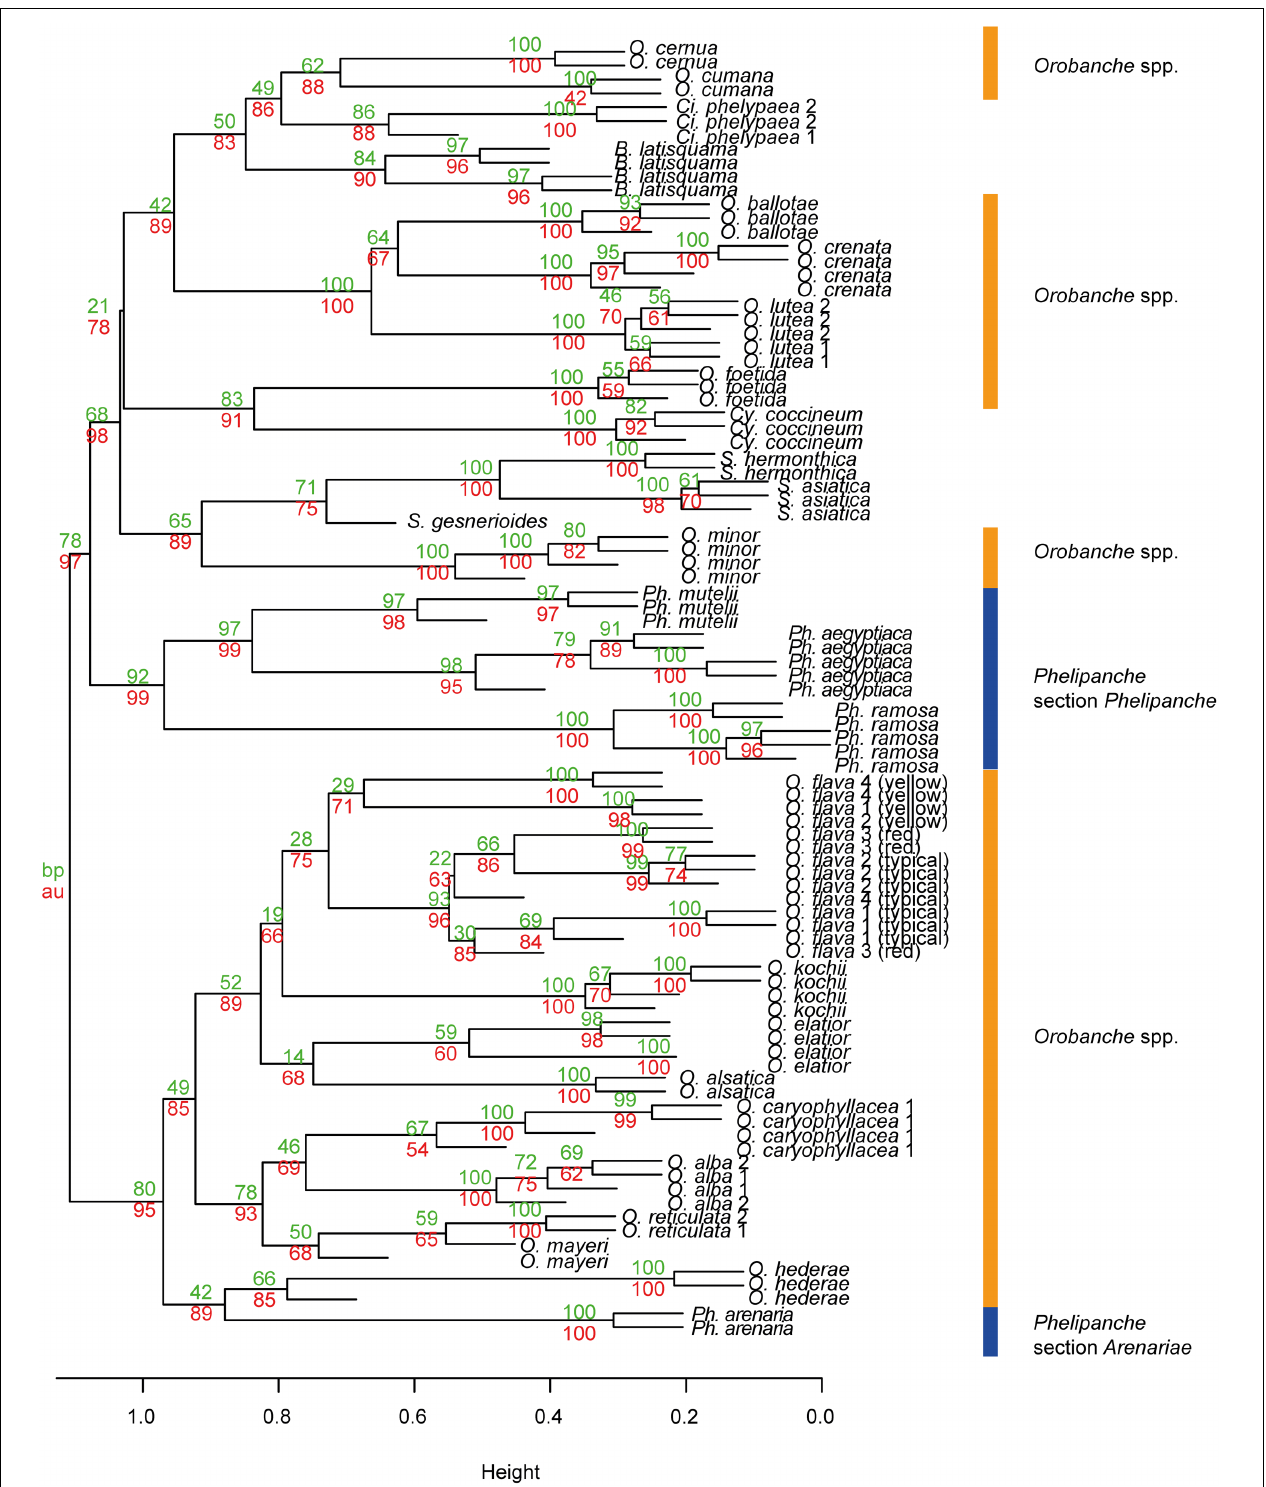
FIGURE 4 | Hierarchical clustering diagram of the flower VOC profiles of all parasitic plant species studied. HCA was performed with R and it was based on PCA of significantly different flower blends after all non-parasitic plant species where removed from the data set. Numbers at nodes are bootstrap probability P -value (BP, upper green numbers) and approximately unbiased P -values (AU, lower red numbers). The definition of the two genera of Orobanche is designated by orange (genus Orobanche ) and blue (genus Phelipanche ) bars; section Arenariae is also indicated (subsections within genus Orobanche are shown in Figure 6 ).